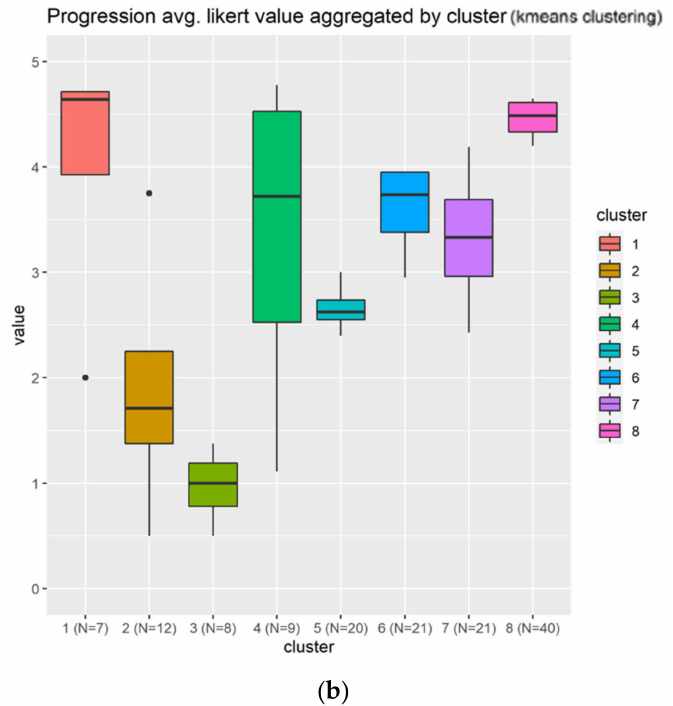
Figure 10. Results for the progression related questions. A total of four related questions in subplot ( a ) and eight boxplots generated in subplot ( b